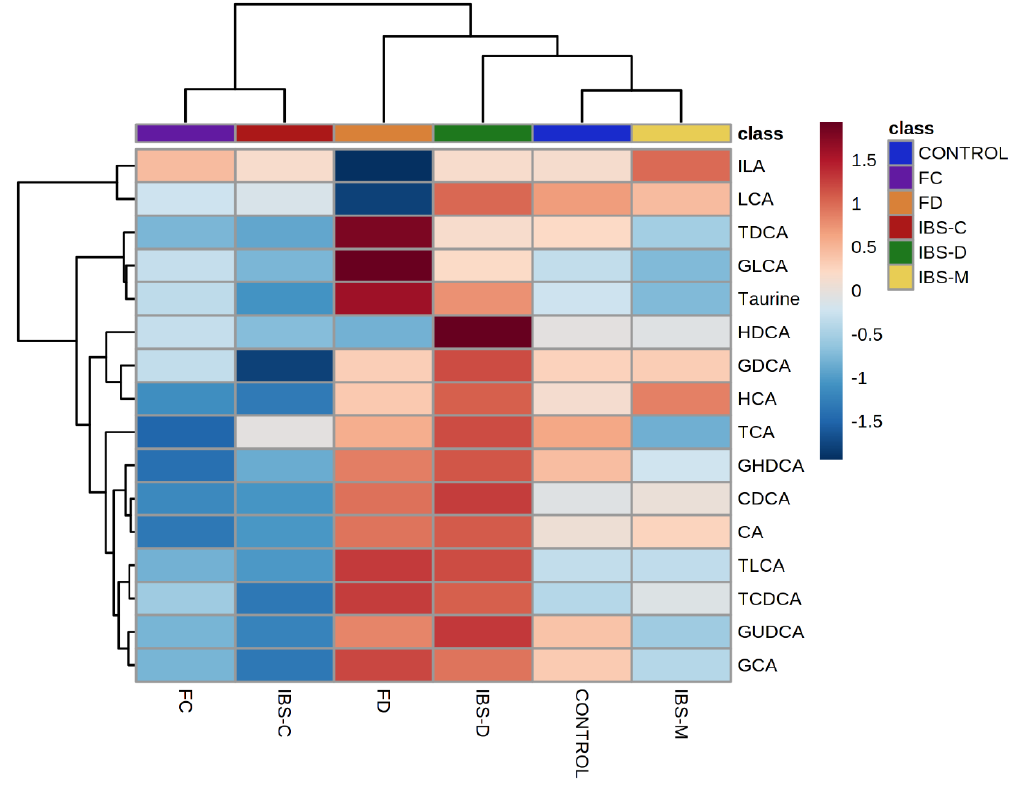
Figure 3. Hierarchical clustering analysis for average values of groups. Healthy control (control), functional constipation (FC), IBS-constipation (IBS-C), functional diarrhea (FD), IBS-diarrhea (IBS-D), IBS-mixed (IBS-M). Data presented as z score of logged values of µg/mg. Color ribbon beneath upper dendrogram identifies groups; healthy control—blue, IBS-C—red, IBS-D—green, IBS-M—yellow, FC—purple, FD—orange.